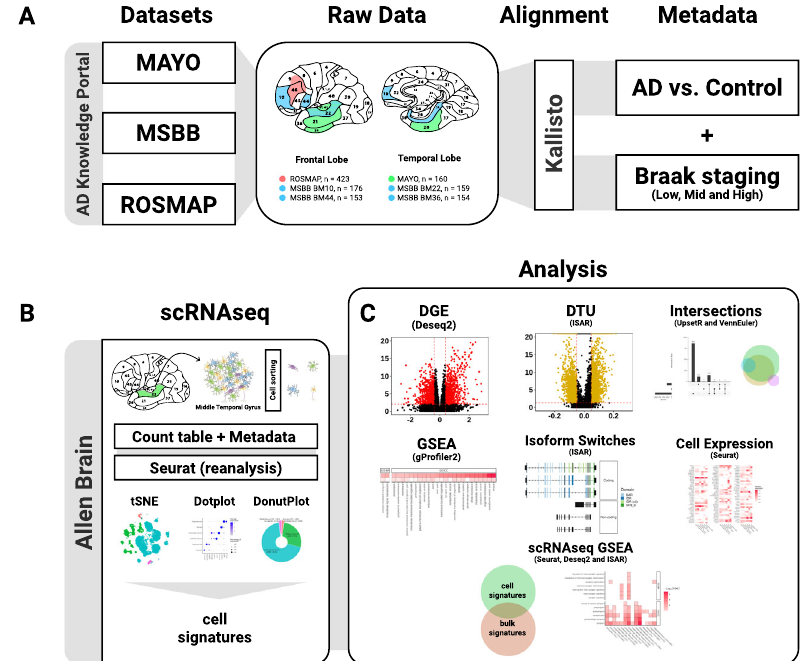
Fig. 1 Schematic summary of the methodology. A Datasets obtained from three consortia (Mayo, MSBB, and ROSMAP) were grouped according to the brain region sampled in the frontal lobe (FL) or temporal lobe (TL). Next, RNAseq data were pseudo-aligned using Kallisto. Clinico-pathological classi fi cations were included as metada. B scRNAseq data from the midle temporal gyrus (MTG, Allen Brain Atlas) were analyzed using the R package SEURAT. C Gene expression analyses were performed using the R packages DESeq2, IsoformSwitchAnalyzeR (ISAR), and gene set enrichment analysis (GSEA). Assignment of differentially expressed genes or isoform switches to speci fi c cell types/ subtypes was performed indirectly using scRNAseq signatures obtained from the MTG